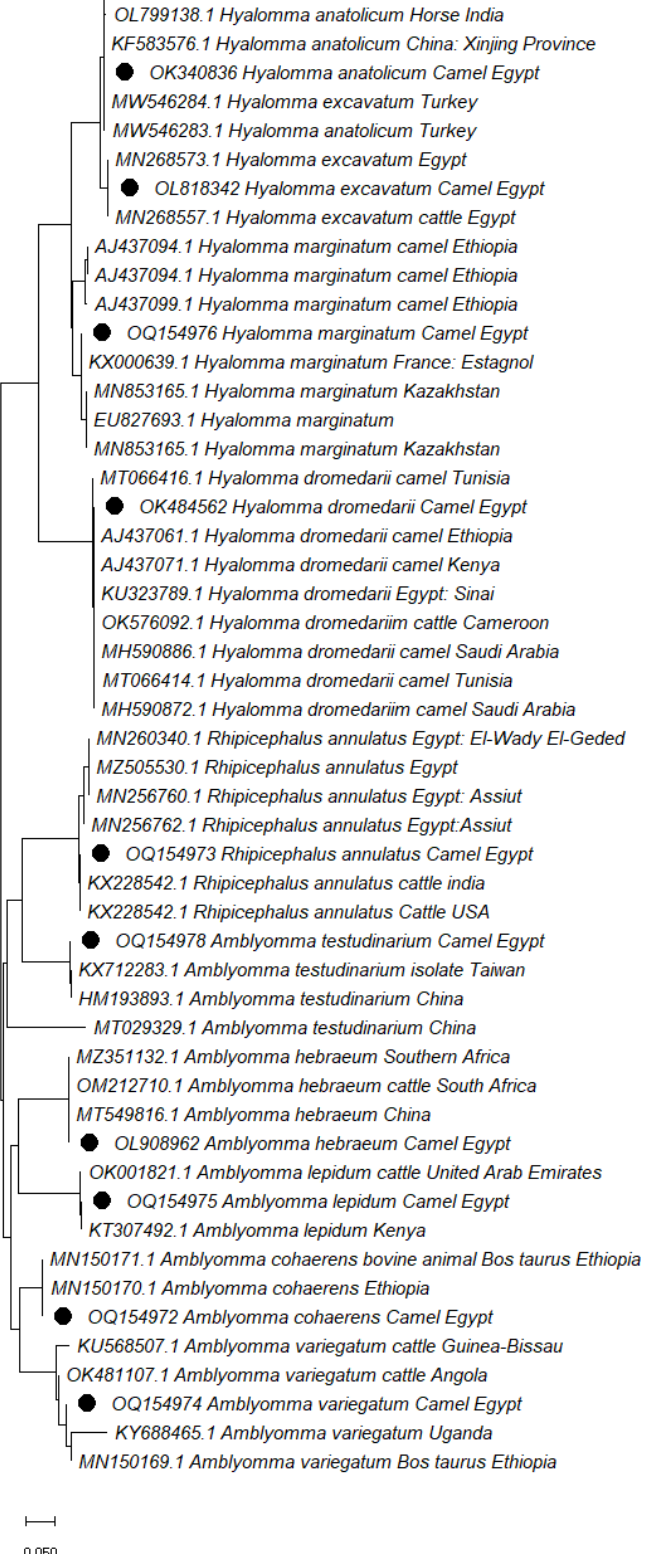
Figure 1. Phylogenetic relationship of tick species collected from camels based on cytochrome c oxidase subunit 1 ( cox1 ) gene. The accession numbers with black dots are from this study.